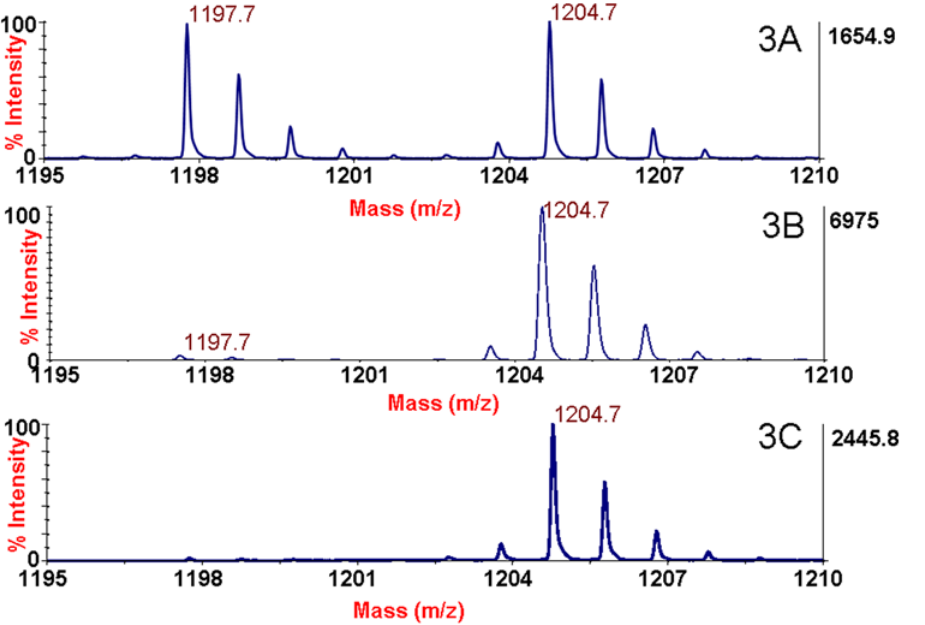
Figure 3. Mass spectra of the Endopep-MS botulinum neurotoxin A reaction after extraction of the toxin with either CR2 (3A), ING2 (3B), or B4 (3C) antibodies. The peptide cleavage product indicating the presence of BoNT/A is present in both cases at m/z 1197.7 and the internal standard is present at m/z 1204.7.